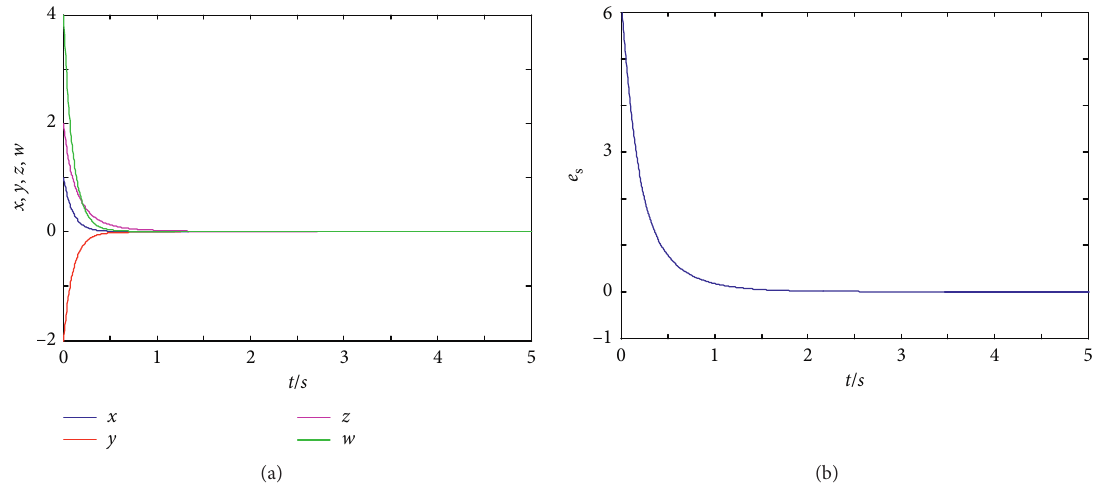
Figure 11: Control charts of the controlled chaotic system. (a) Time response of state variables. (b) The estimation error of parameter s .